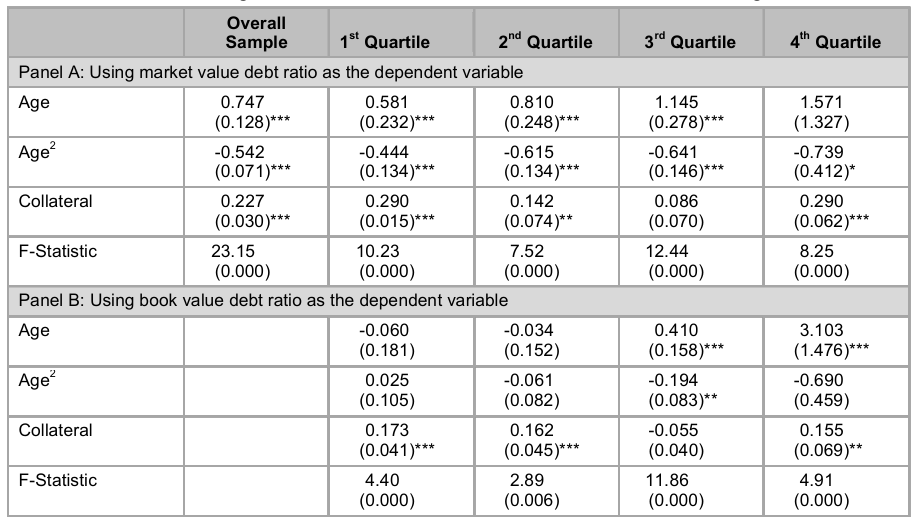
Coefficients for age and collateral variables based on fixed effects regressions Overall Sample 1 st Quartile 2 nd Quartile 3 rd Quartile 4 th